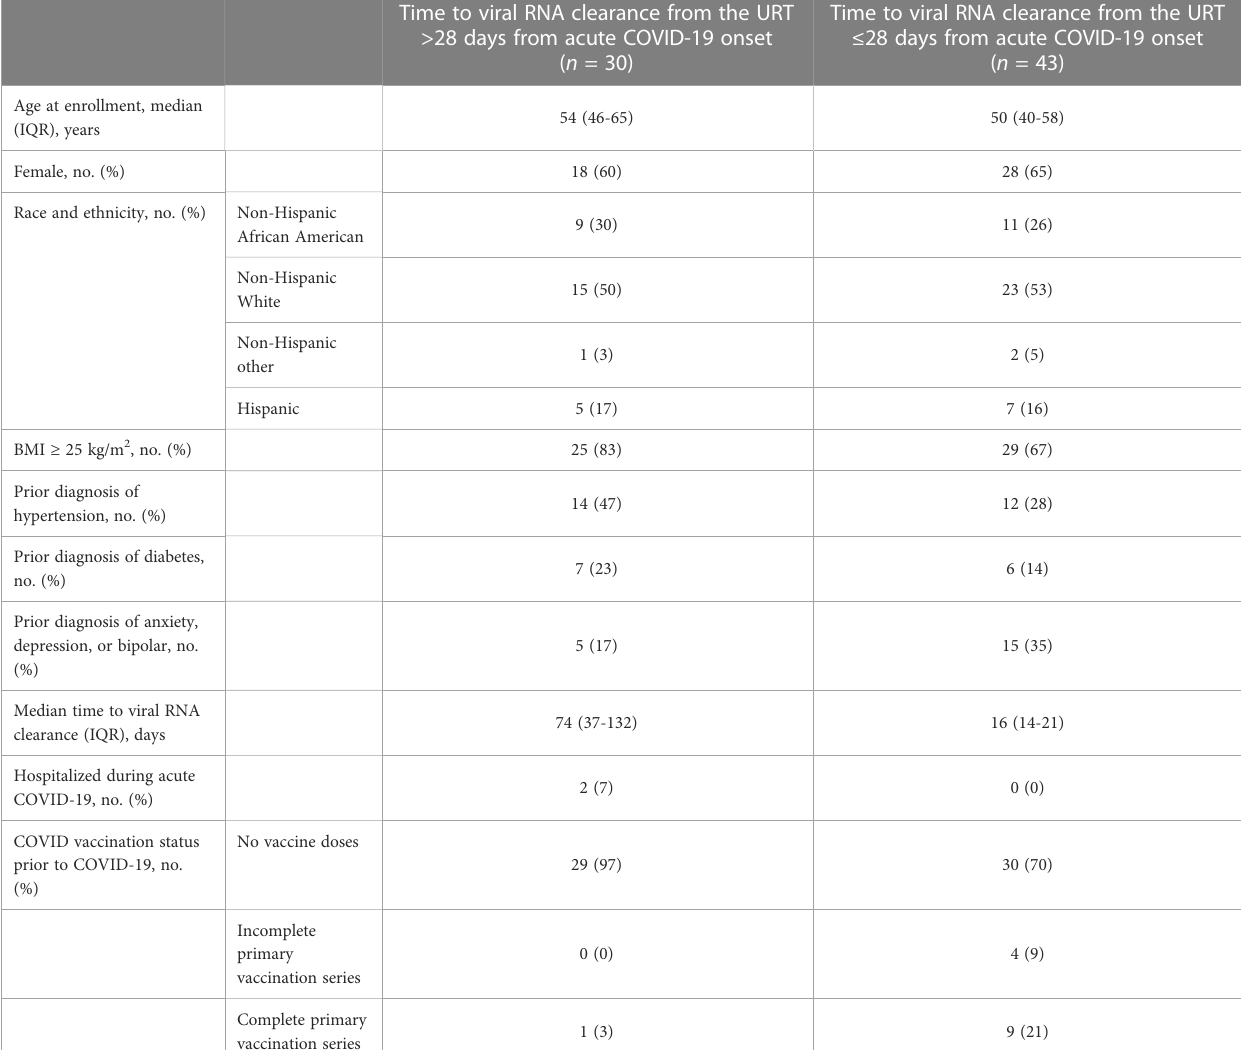
TABLE 2 Participants ’ demographics, body mass index, and pre-COVID vaccination